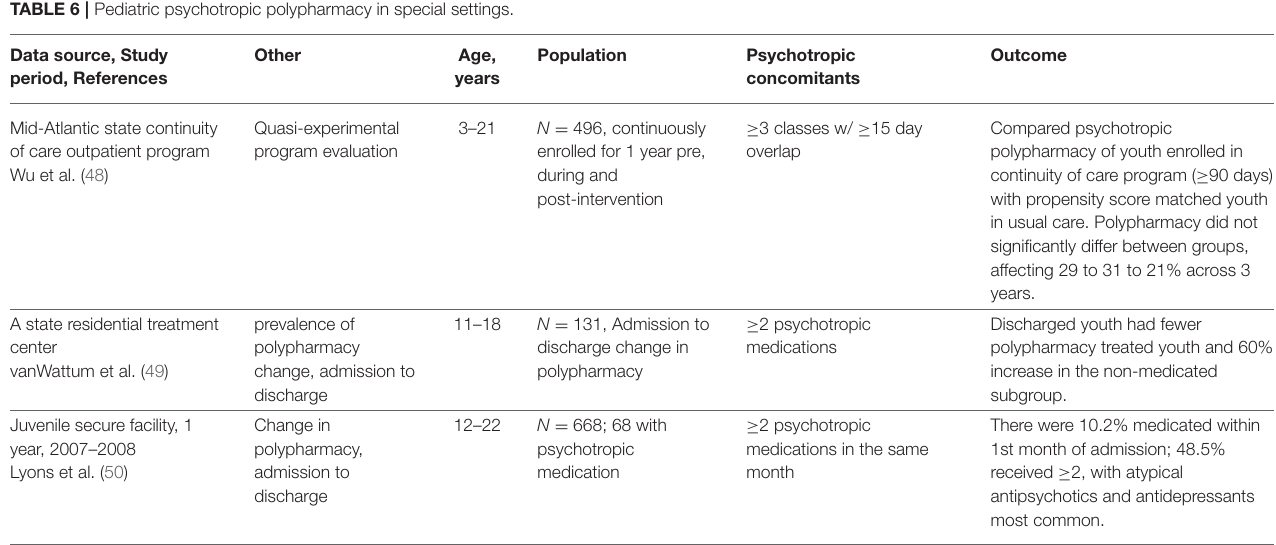
TABLE 6 | Pediatric psychotropic polypharmacy in special